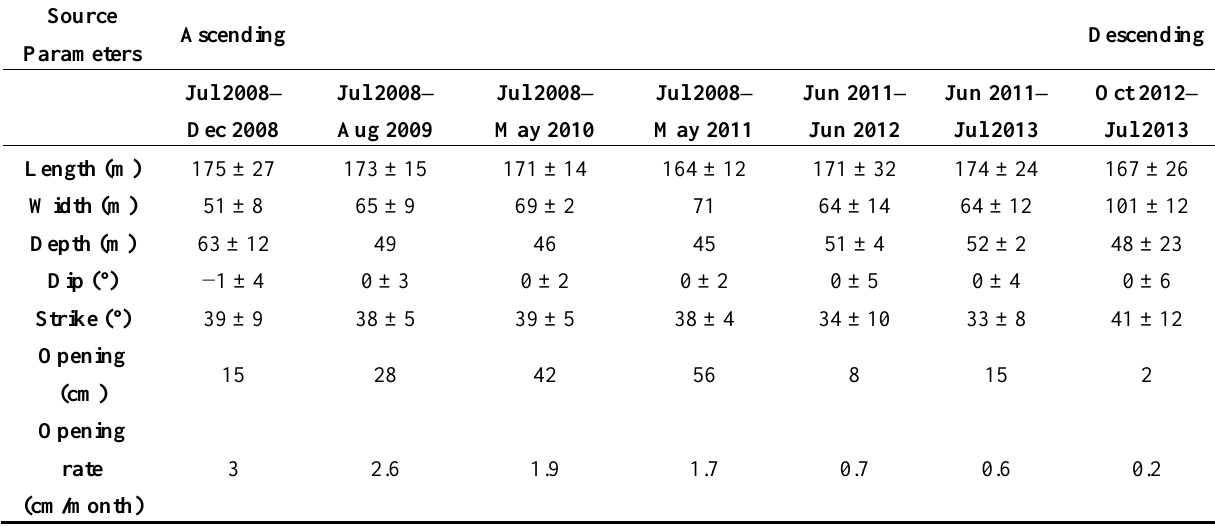
Table 2. Source parameters from inversion of different Synthetic Aperture Radar Interferometry (InSAR) datasets for different time periods as presented in Figure 4. The standard deviation has been computed from conditional posterior probability density unimodal posterior